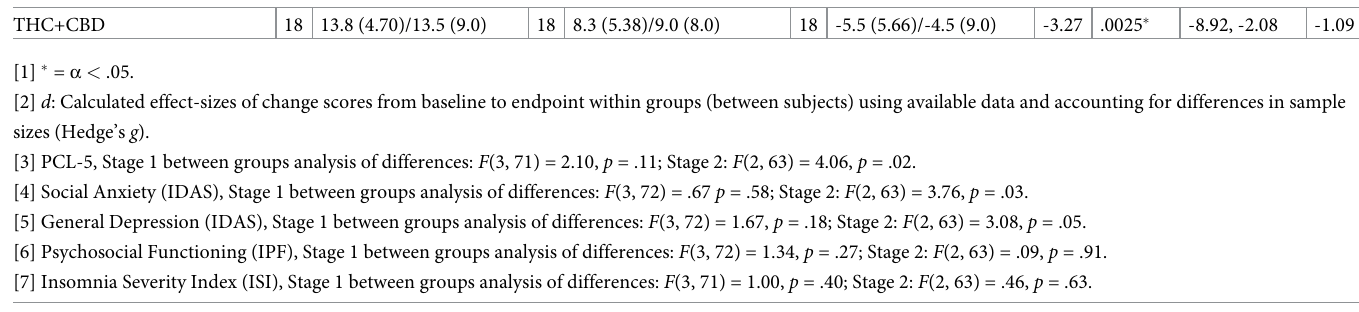
subscale scores ( Δ = 1.9, 95% CI: 0.38, 3.35, d = -.97) and CAPS-5 D (negative thoughts and emotions) subscale scores ( Δ = 5.2, 95% CI = 2.04, 8.26, d = -1.13), and between High THC and THC+CBD group participants in mean change in CAPS-5 D (negative thoughts and emo- tions) subscale scores ( Δ = 4.1, 95% CI: 1.09, 7.15, d = -1.01). In Stage 2, there were no